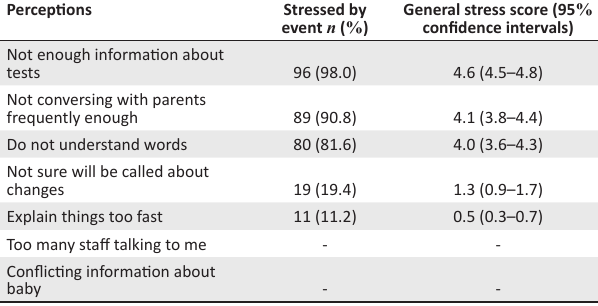
TABLE 2: Parents’ perceptions of sights and sounds in the NICU ( n = 98). Perceptions